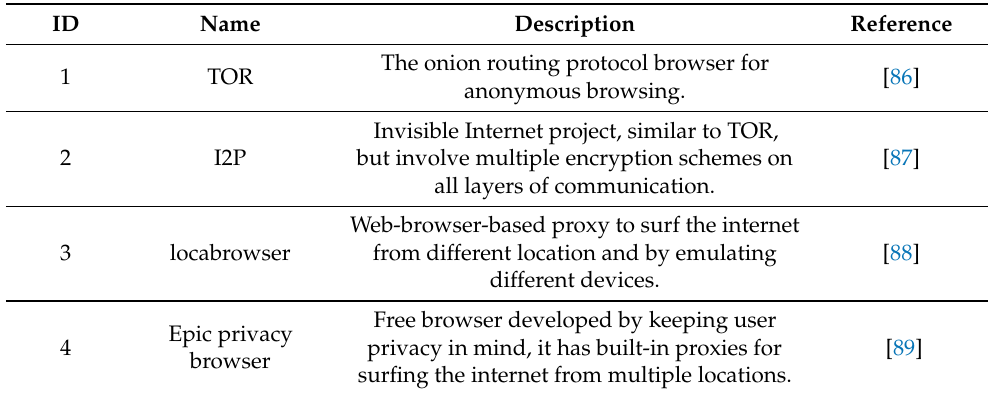
Table 20. Tools used for secure